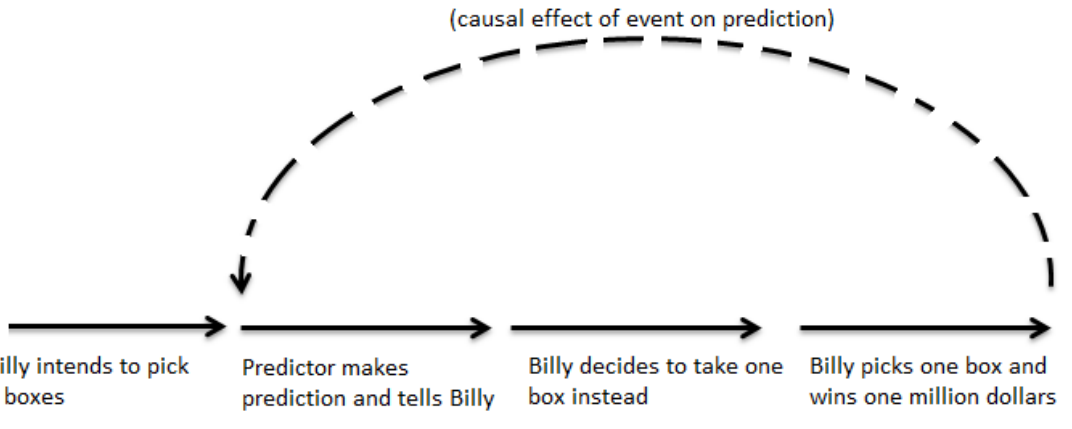
Figure 5. A candidate CEN loop.